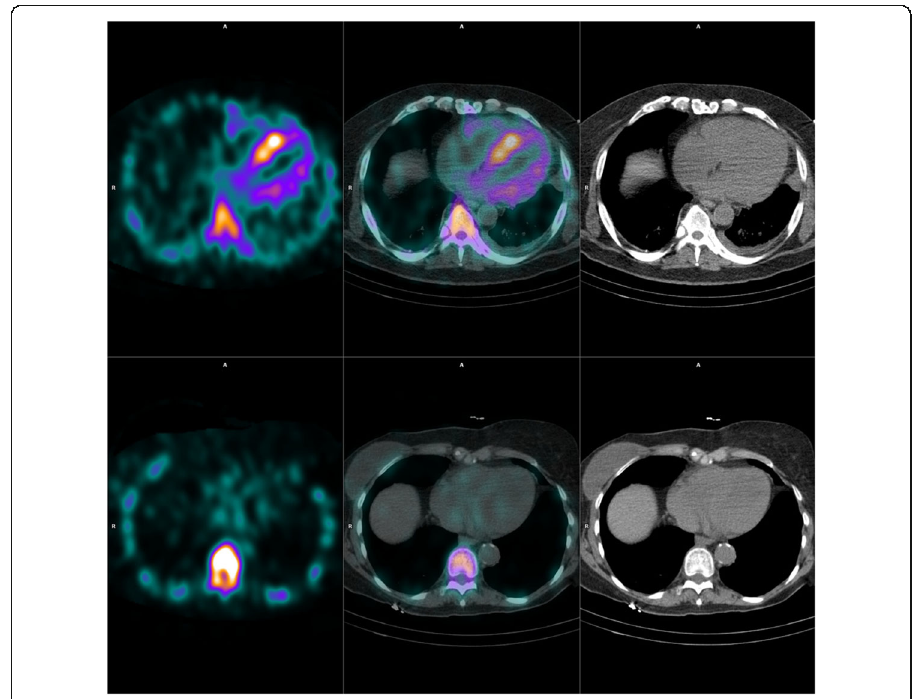
Fig. 1 Examples of xSPECT/CT transaxial images through the heart at midventricular level. The upper row is from a patient with ATTR cardiac amyloid, planar imaging in this individual showed Perugini grade 2. The lower row is from a patient with no known heart disease (history of previous right breast cancer)